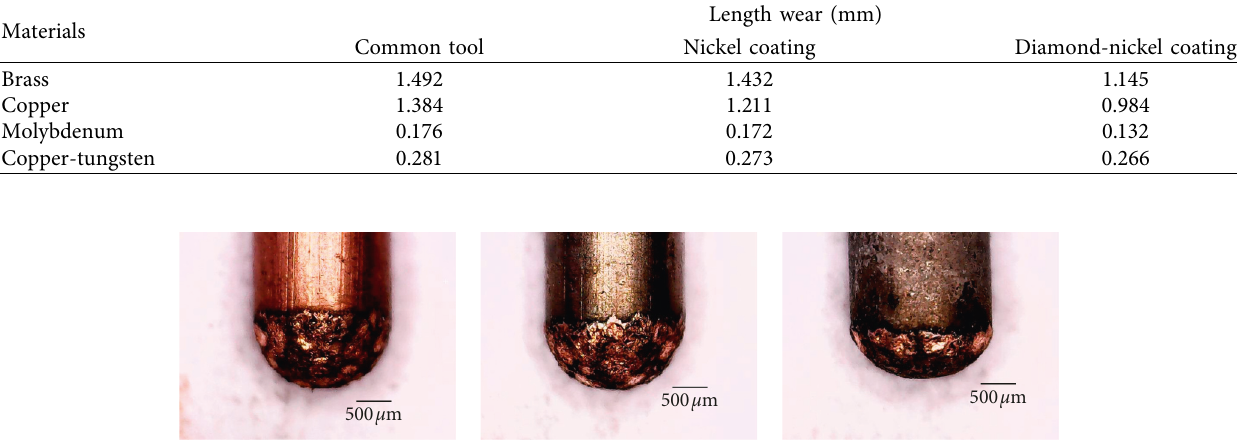
Table 7: Length wear of different coated tools.